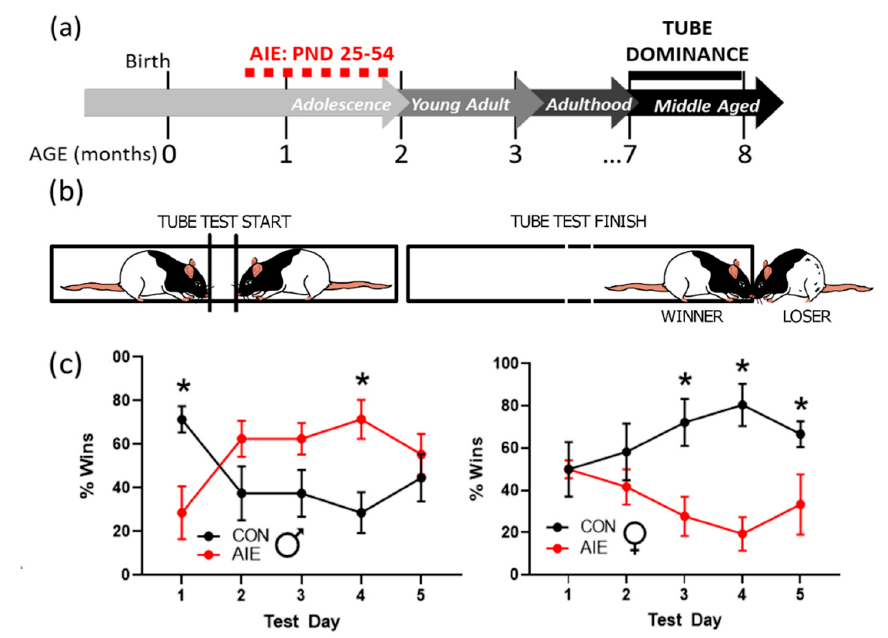
Figure 5. AIE increases submissive responses in the tube dominance test. ( a ) Timeline of tube dominance testing paradigm. Rats underwent AIE or CON gavage paradigms from PND 25–54. The tube dominance test was conducted later in adulthood (7–8 months of age). Males were tested first, followed by females. ( b ) Rats were placed on either side of a clear plexiglass tube and separated by removable gates. The test began when both rats were waiting at the gates, and the gates were removed. The test ended when one rat pushed the other out of the tube. Winning was scored as a binary win ‐ lose. ( c ) Male rats exposed to AIE were more submissive on the initial test day, although this effect was transient where AIE males were more likely to win encounters by the fourth test day. In contrast, female rats exposed to AIE were increasingly more submissive with each test. Results are expressed